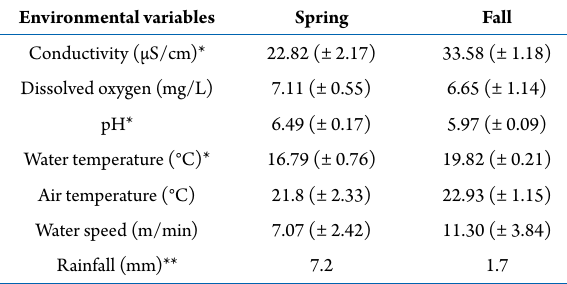
Table 1. Mean values (± standard deviation) of the environmental variables recorded in spring 2010 and in fall 2011. * = p < 0.05. **The rainfalls were provided by the weather station at Universidade Federal de Santa Maria for a 15 days period, in which the study was